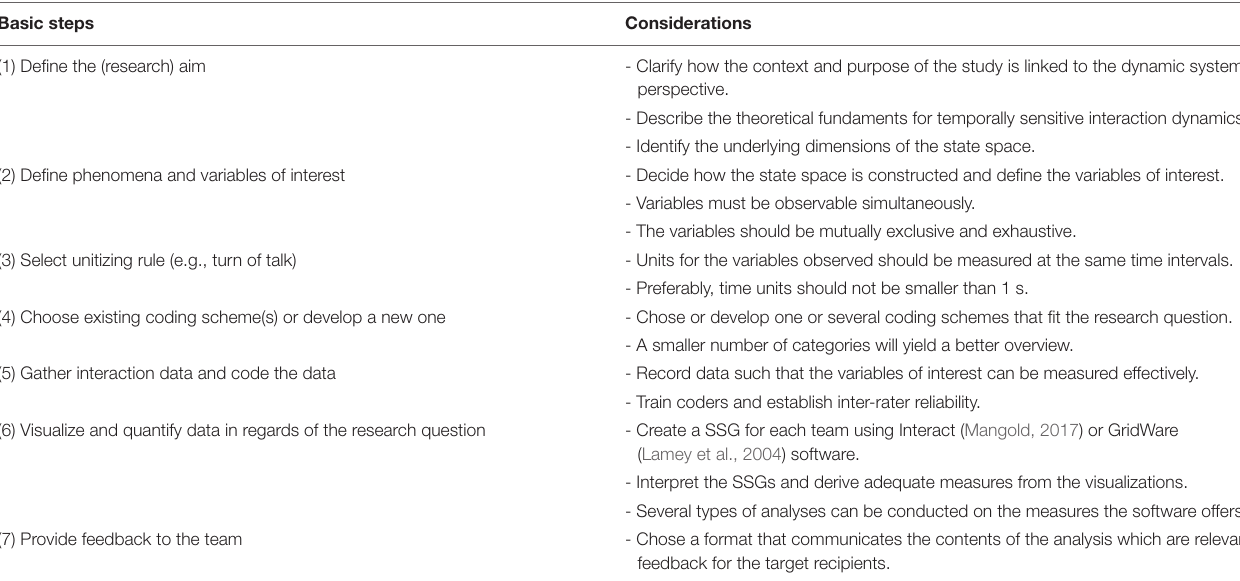
TABLE 1 | Basic steps for applying SSGs in team research.